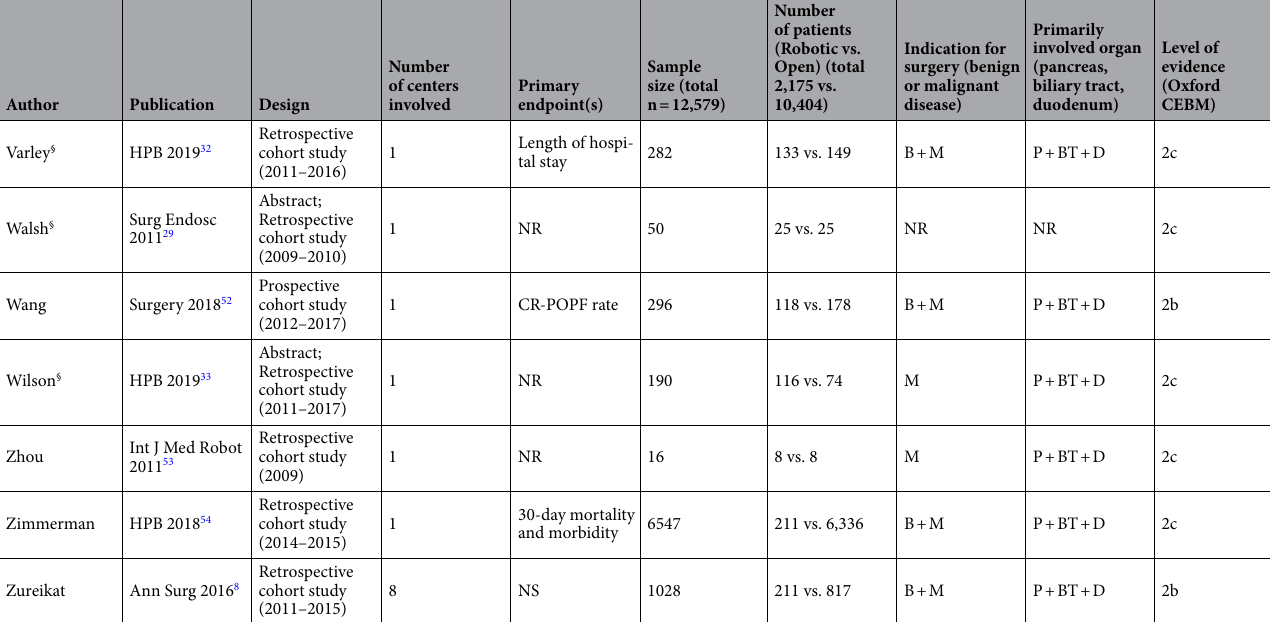
Table 1. Characteristics of included studies. CEBM Centers for Evidence-Based Medicine; B benign; M malignant; P pancreas; BT biliary tract; D duodenum; NR not reported; NS not specified. § Studies that were excluded from the quantitative